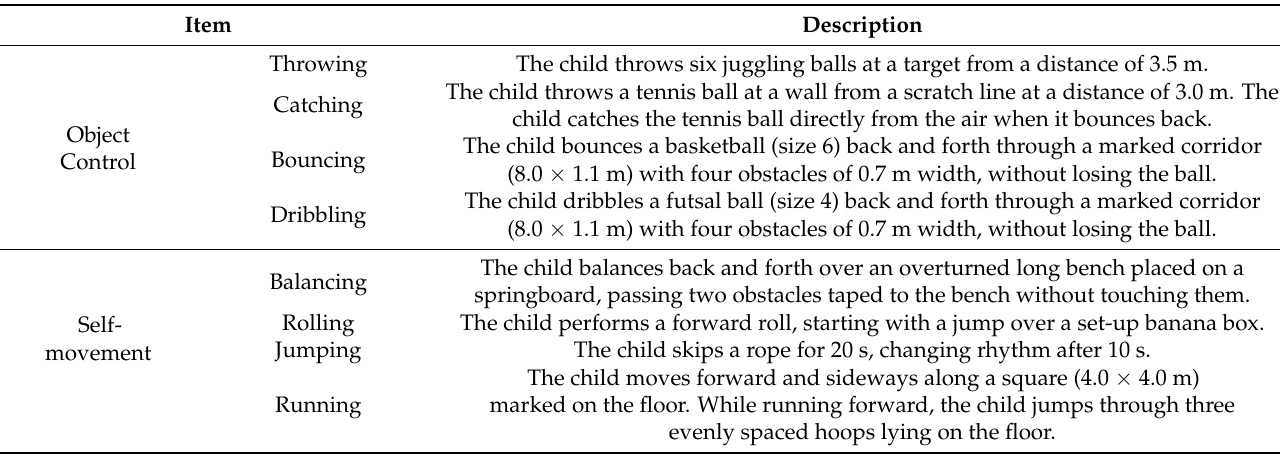
Table 1. Description of the items in the MOBAK 5-6 test [26].